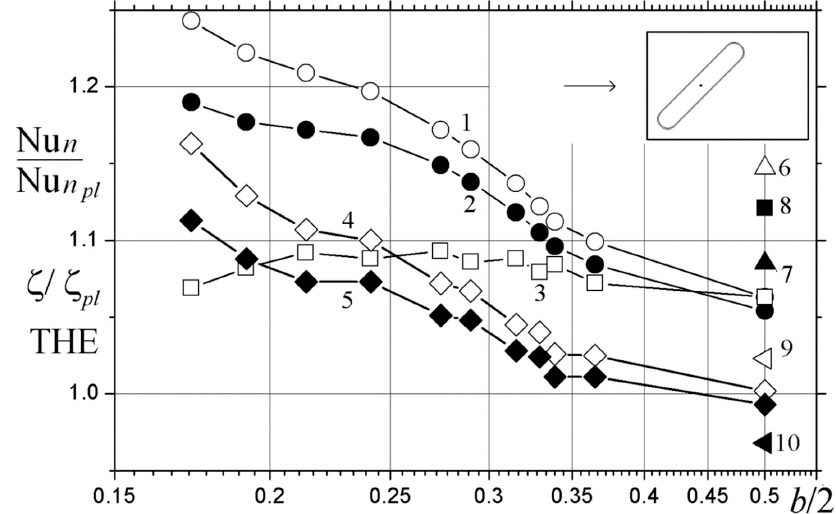
Figure 16. Influence of the oval dimple width b on thermal (1,2,6,7) and thermal-hydraulic (4,5,9,10) performances, as well as relative hydraulic losses (3,8); 6,7,8,9,10—conical dimple; 2,5,7,10—with regard to the area of the dimple inner surface in the 3 × 2 section and the shift of the dimple center by 1 from the front